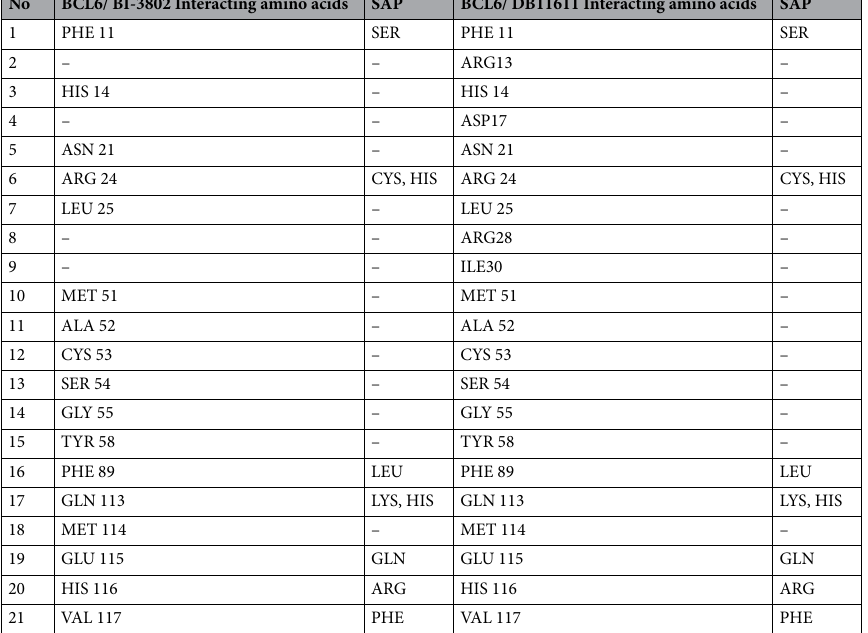
Table 2. Single amino acid polymorphisms (SAP) among BLC6 amino acids, which interact with BI-3802 and